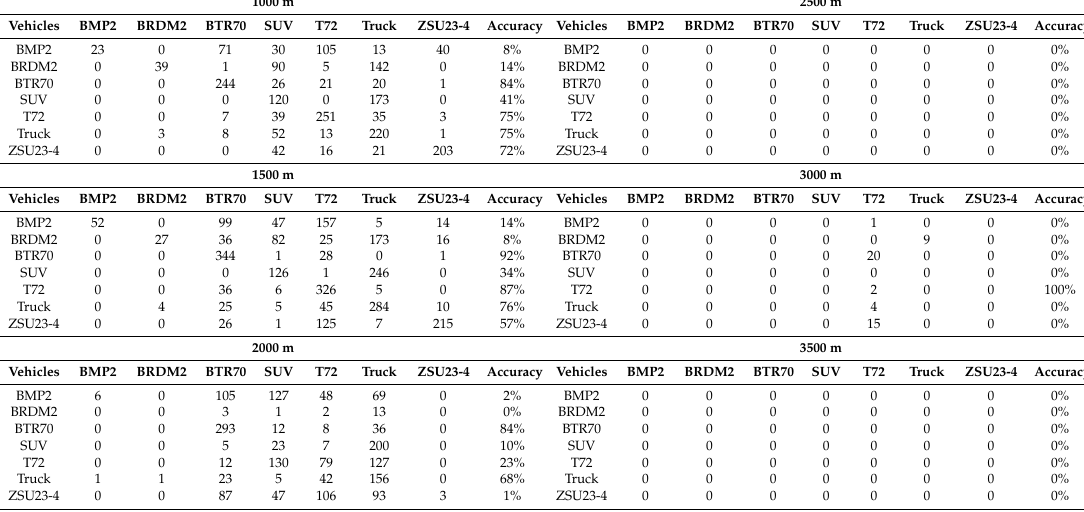
Table A3. Classification results for PCE 50 (optical video) case. Left shows the confusion matrix and the last column shows the classification accuracy. 1000m